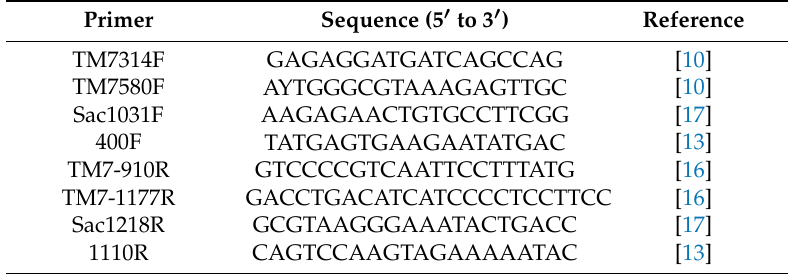
Table 1. Saccharibacteria-specific primers targeting the 16S rRNA gene evaluated in this study.